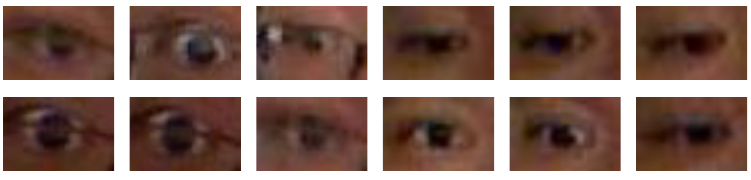
Figure 12. Example eye images.